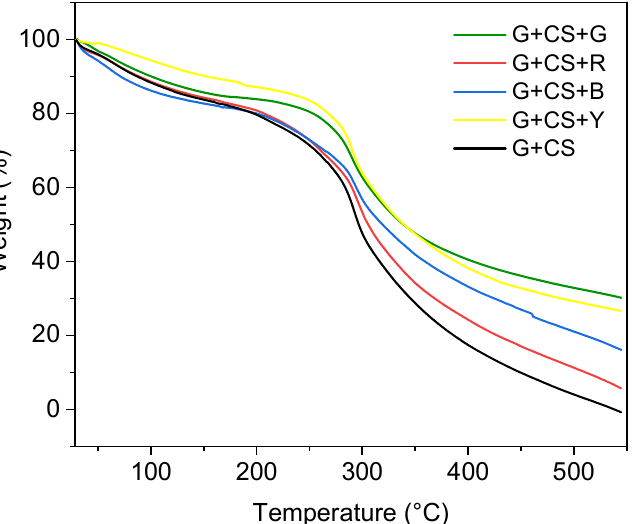
Figure 9. Thermogravimetric analysis (TGA) of the simple gelatin–cornstarch-based film (black line) and the films with food color addition. The blue curve represents the G+CS+B film, the red curve represents the G+CS+R film, the green curve represents the G+CS+G film, and the yellow curve represents the G+CS+Y film.